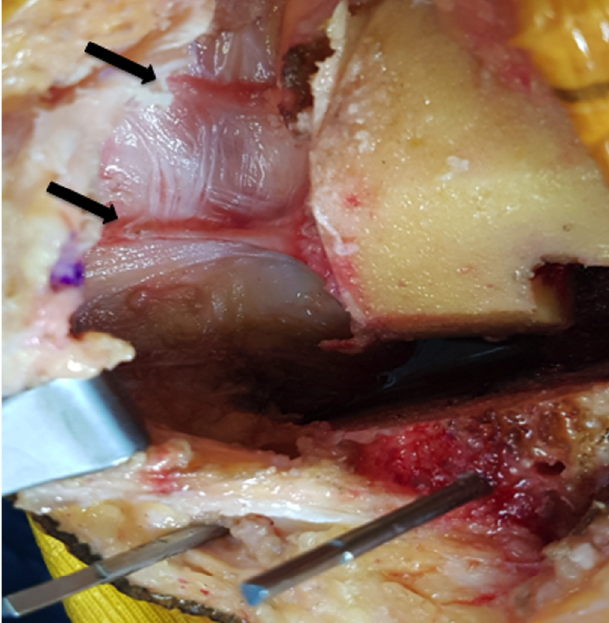
Figure 4. Lateral synovial folds are identi fi ed and